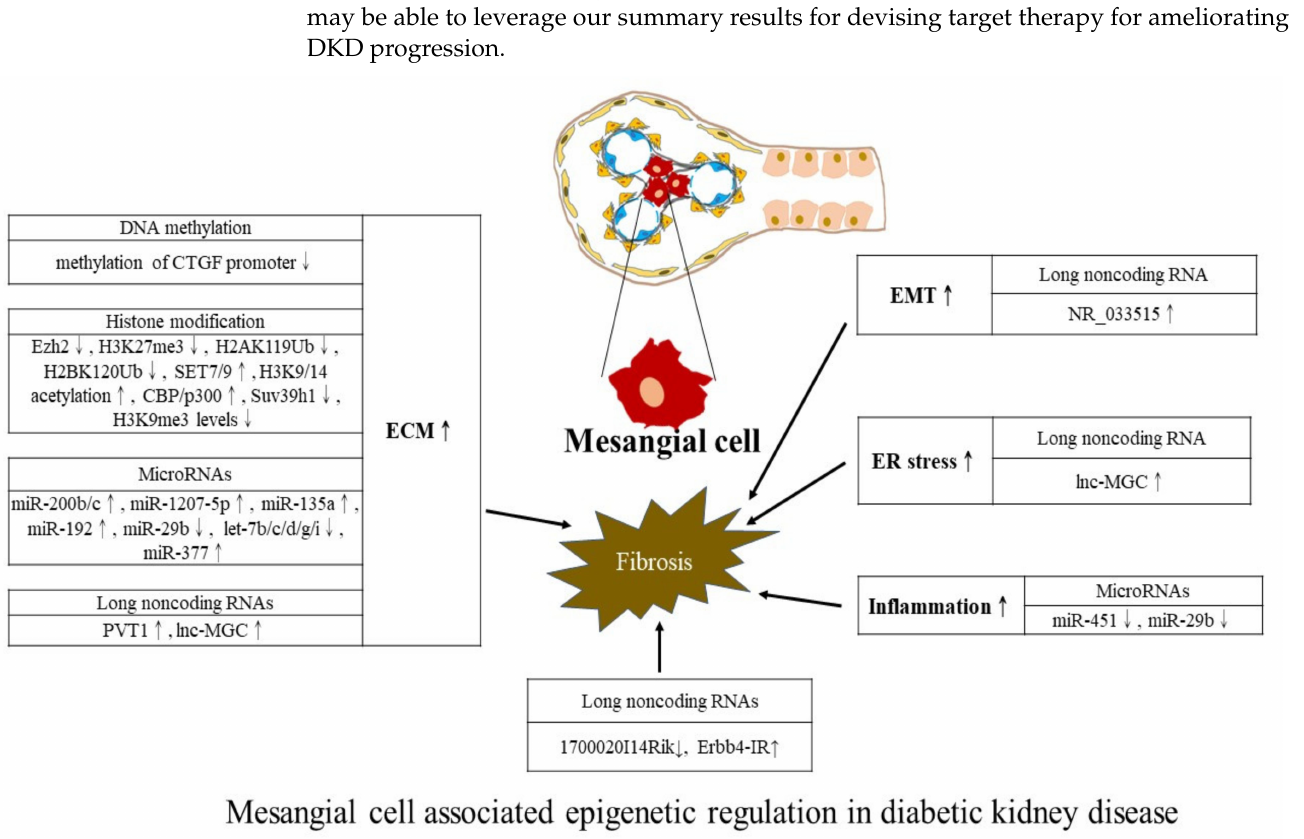
Figure 2. Mesangial cell associated epigenetic regulation in DKD. Denote: ECM: Extracellular matrix, EMT: Epithelial-to-mesenchymal transition, and ER: Endoplasmic reticulum. Symbols: ↑ refers to increase; ↓ refers to